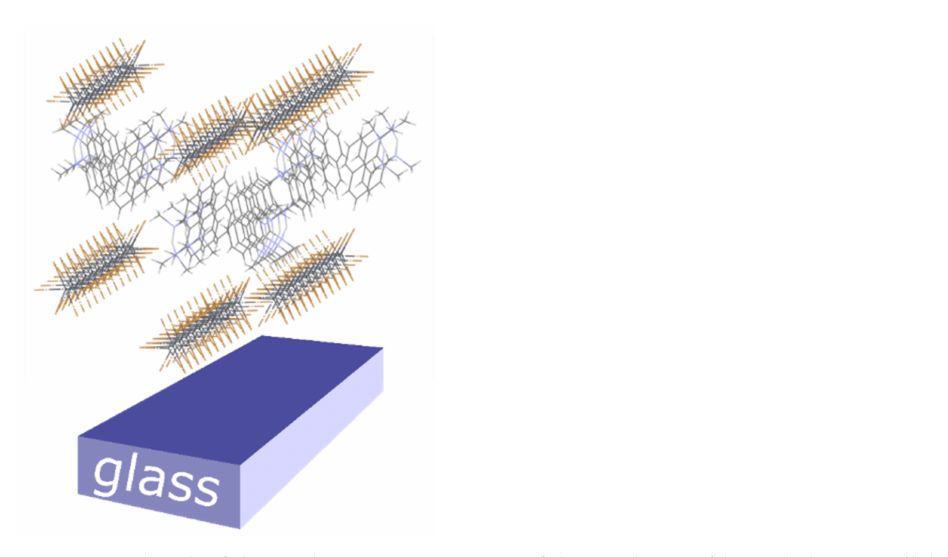
Figure 5. A sketch of the predominant orientation of the 1D chains of (PRSH)PbX 3 , parallel to the substrate surface, as determined by XRD and